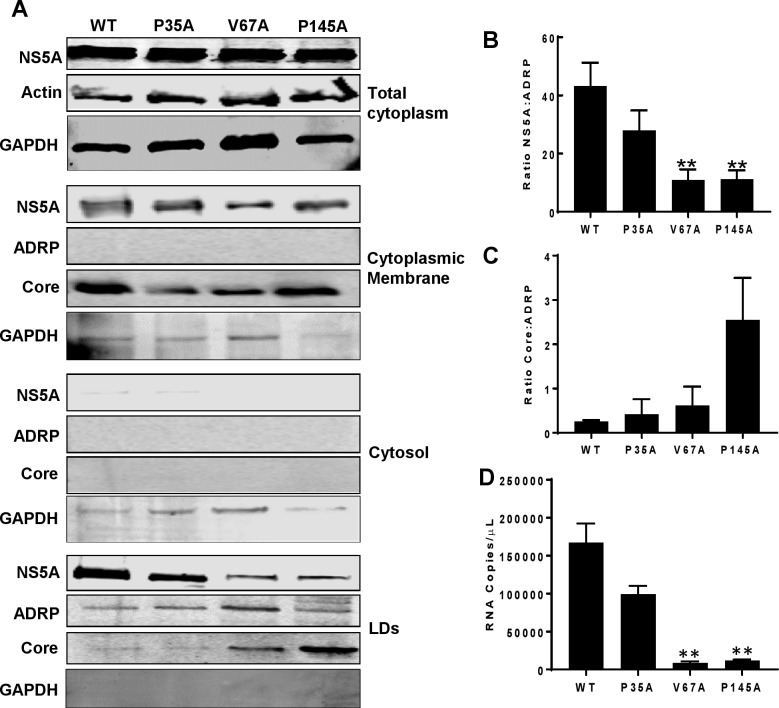
V67A and P145A disrupt the recruitment of NS5A and Core to LDs.A Western blot analysis of NS5A and Core proteins, the LD marker protein ADRP and GAPDH in purified LD fractions compared with whole cytoplasm, cytoplasmic membrane and cytosolic fractions. The abundance of NS5A (B) and Core (C) in the LD fractions was quantified and normalised to the LD fraction ADRP value. D Amount of viral RNA in LD fractions was determined by qRT-PCR. Error bars represent the standard error of the mean of three independent experiments. ** indicates significant difference (P<0.01) from WT.